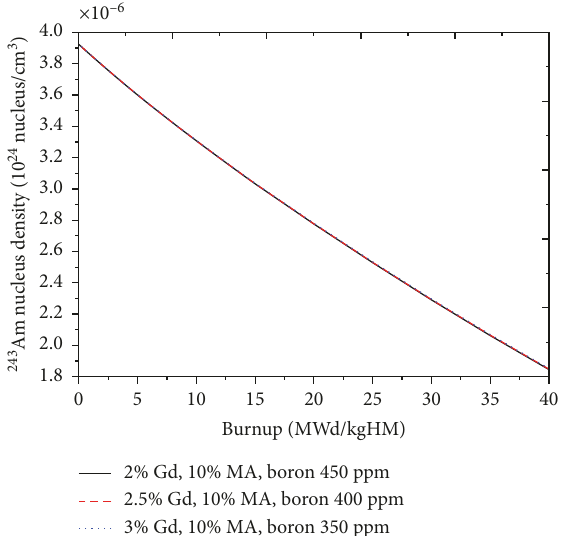
Figure 15: Transmutation of 243 Am versus burnup when loading 10wt.% of